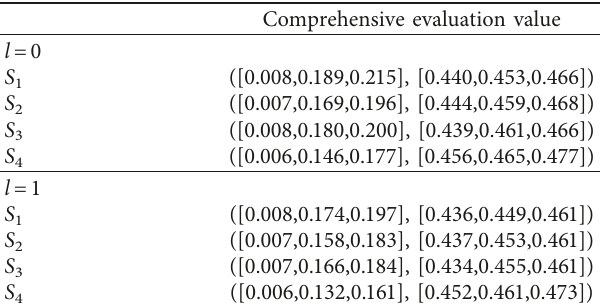
Table 7: The comprehensive evaluation value under the fully objective/subjective information.